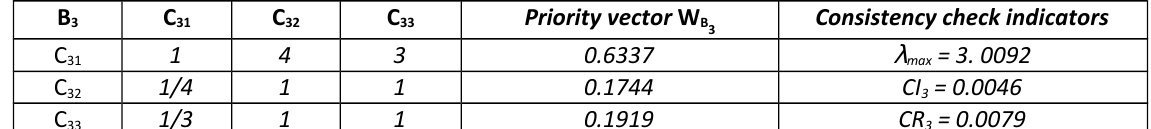
Table 6. Alternative matrix B